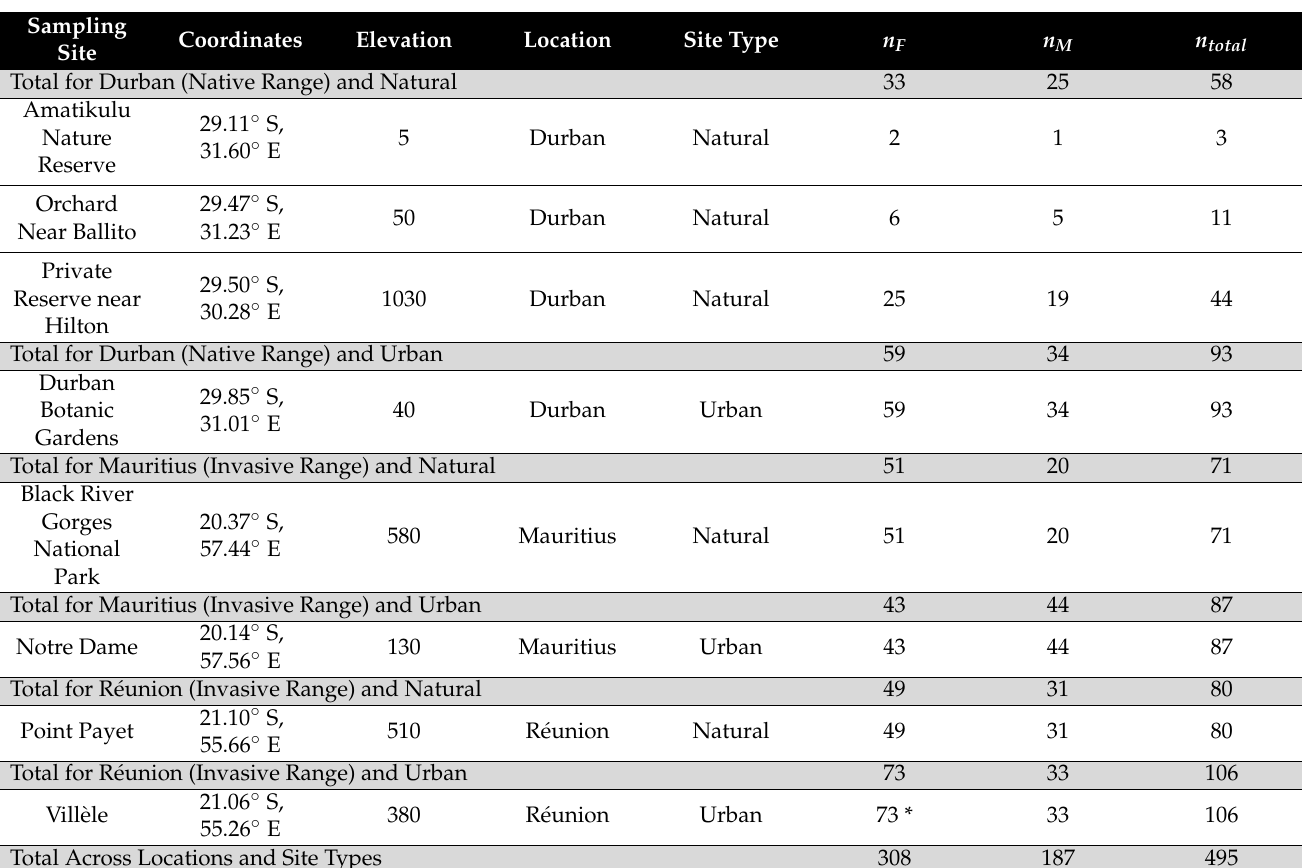
Table 1. Sample sizes of the guttural toads ( Sclerophrys gutturalis ) for which morphological data were recorded, separated by study location, site type, sex (F/M), and population. Durban is within the native range of this species and hosts the source population of the two studied locations within its invasive range (Mauritius and R é union). We also note the latitude, longitude, and elevation (m a.s.l.) of our sampling sites. Inconsistences in the sample sizes of measurements are identified